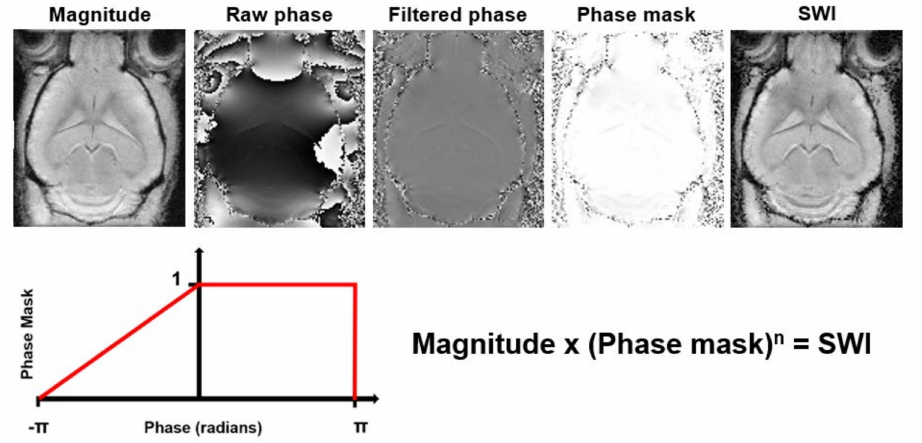
Figure 7. Processing steps to generate Susceptibility Weighted Images (SWI) from magnitude and phase data. The raw phase data are filtered to remove low frequency fluctuations. Then, a phase mask that scales the filtered phase images to a range from 0 to 1 is created. This phase mask is then multiplied several times (n) with the magnitude image to generate the SWI with enhanced